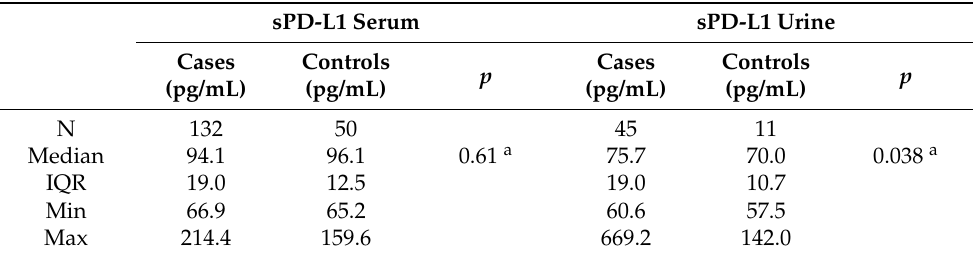
Table 3. sPD-L1 concentration in serum and urine from patients with BC (cases) and patients with macroscopic hematuria without any evidence of BC (controls).